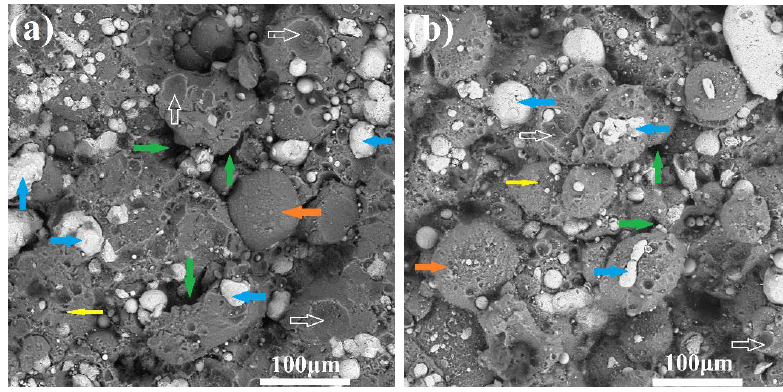
Figure 3. morphologies of the cold-sprayed Ni/Al-TiB 2 coatings at ( a ) 250 and ( b ) 450 °C. Table 1. The details of the surface roughness values of the coatings.